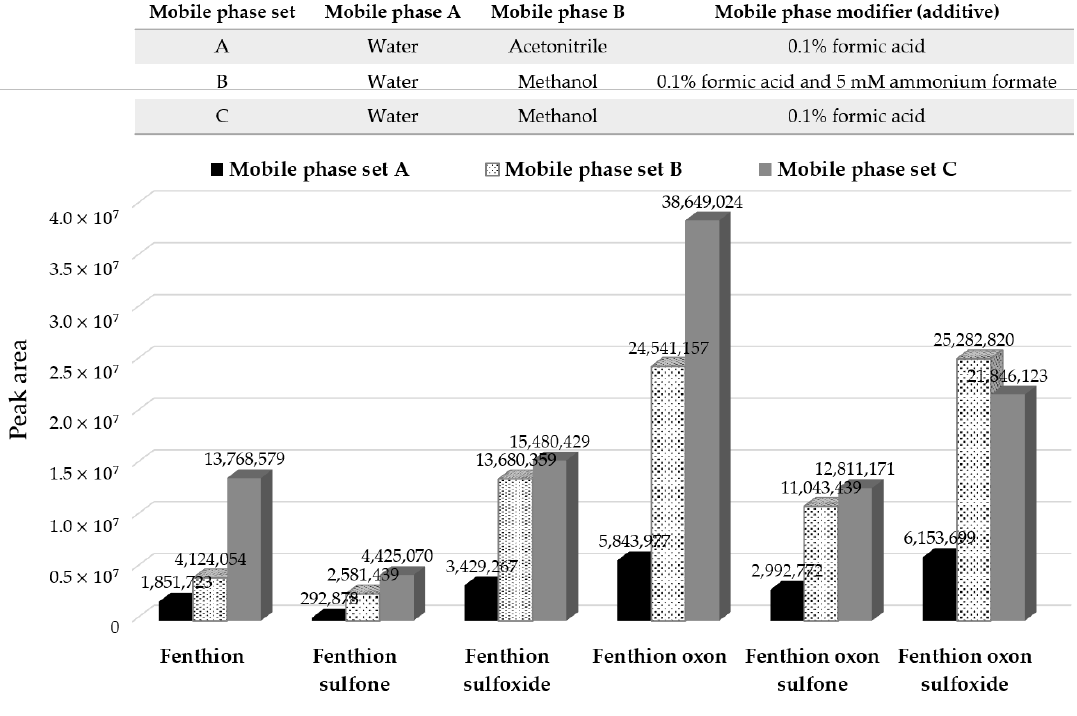
Figure 3. Comparison of the peak responses in standard mixtures of 0.1 µg/mL across the different mobile phases: ( A ) water and acetonitrile (0.1% formic acid); ( B ) water and methanol (5 mM ammonium formate and 0.1% formic acid); and ( C ) water and methanol (0.1% formic acid).